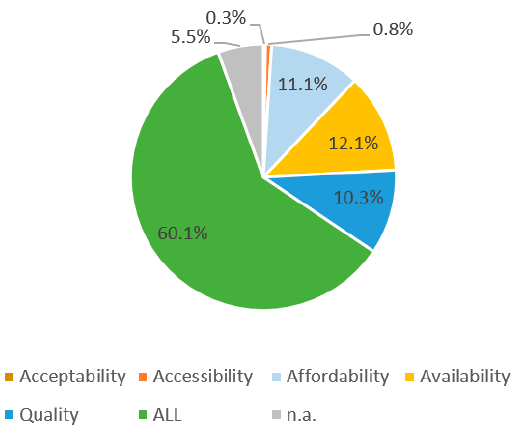
Figure 2. Distribution of recommendations by normative criteria.